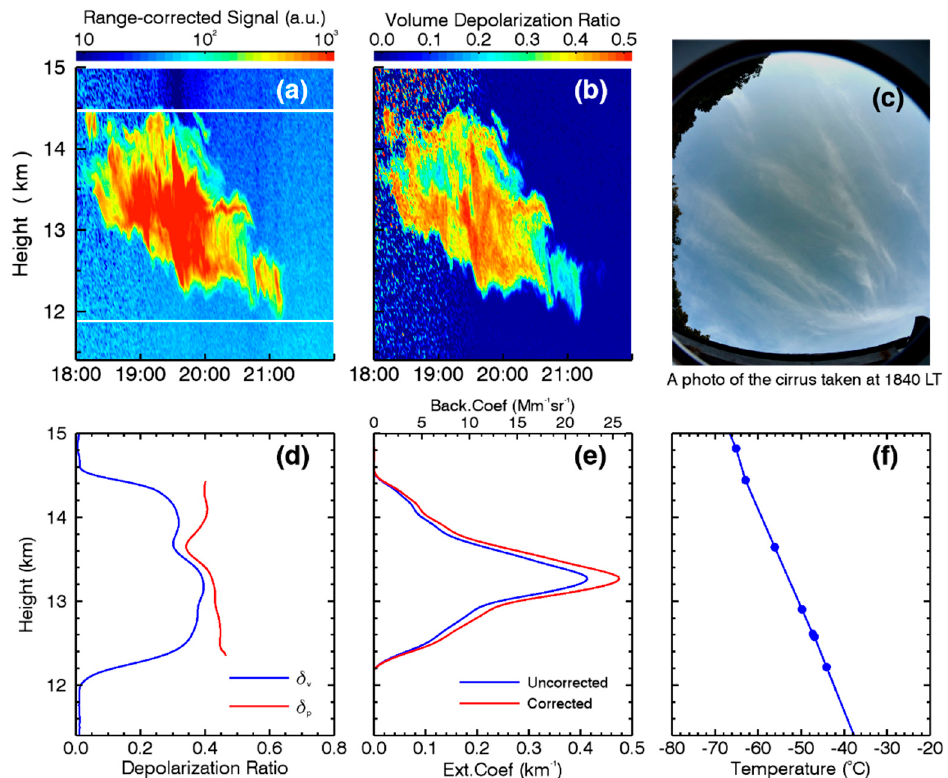
Figure 1. A cirrus cloud example as observed by Wuhan University ground-based 532-nm polarization lidar and all-sky camera on 25 July 2019. Time-height (1 min /30 m resolution) contour plots of ( a ) range-corrected signal and ( b ) volume depolarization ratio. ( c ) A photograph of the cirrus taken at 1840 LT; ( d ) The time-average profile of depolarization ratio (blue curve for volume depolarization ratio, red line for particle depolarization ratio); ( e ) the time-average profile of extinction coefficient and backscatter coefficient with (red) and without (blue) multiple scattering correction; ( f ) temperature profile from radiosonde launched at 2000 LT. The white horizontal lines in panel ( a ) denote the cloud base and top heights, respectively. This example shows a dense cirrus cloud with a COD of 0.44 and mean particle depolarization ratio of 0.41 ± 0.03. It occurred in an altitude range of ~12-14 km with temperature values varying from − 42 to − 64 ° C, lasting for 190 minutes.